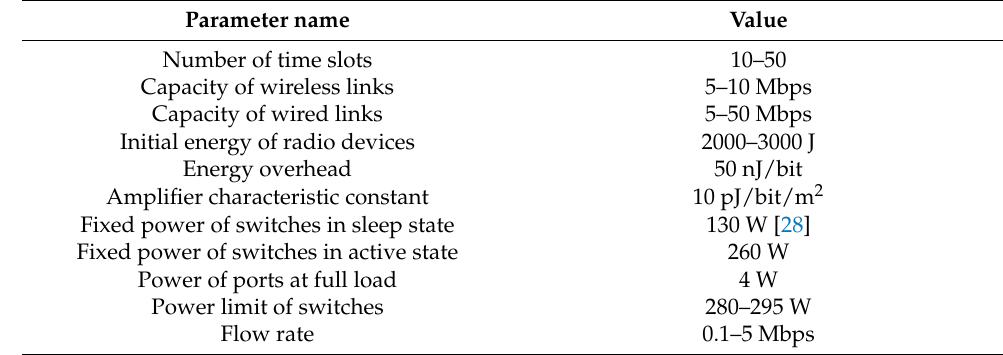
Table 1. Simulation